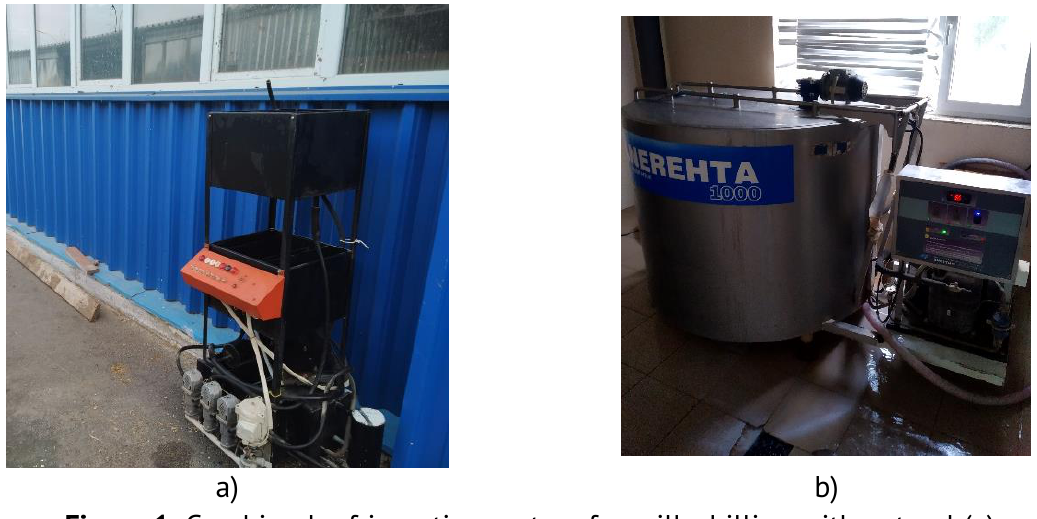
Figure 1. Combined refrigeration system for milk chilling with natural (a) and artificial cold